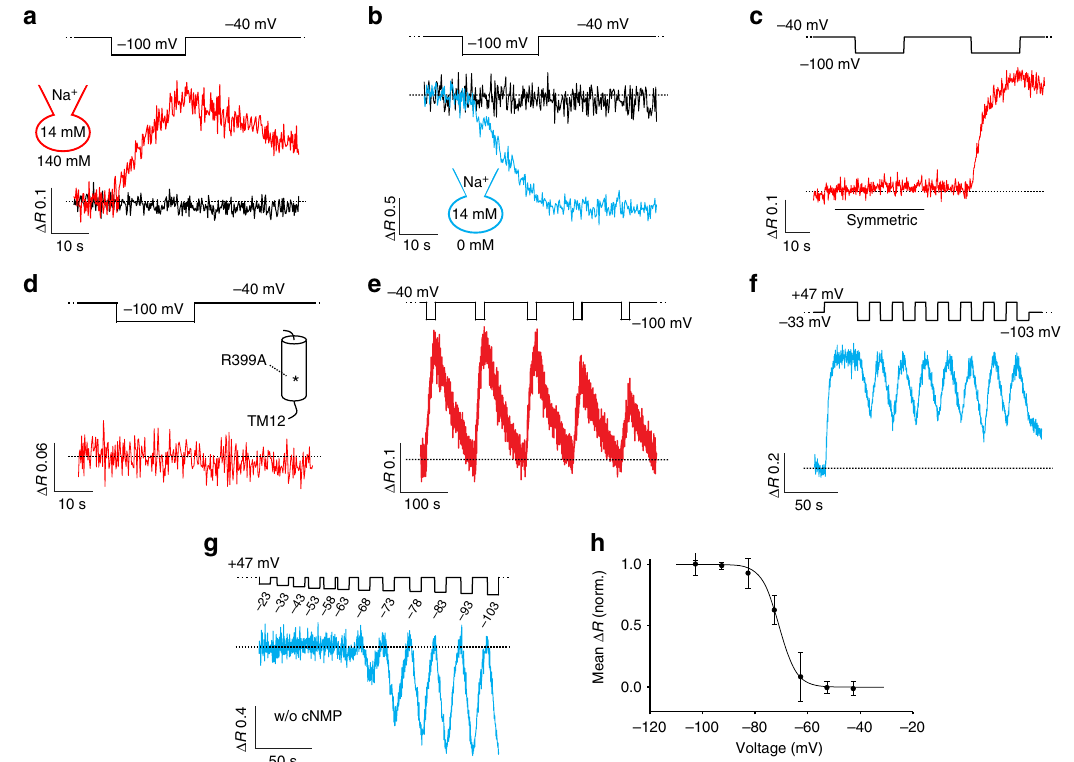
Fig. 3 Voltage-clamp pH i fl uorimetry of Sp SLC9C1 activity. a Alkalinization induced by a 20 s step hyperpolarization to − 100 mV using an inwardly directed Na + gradient ([Na + ] i 14 mM; [Na + ] o 140 mM; pH i = 7.2; pH o = 7.4, forward mode, red). No pH i change occurred in non-transfected CHO cells